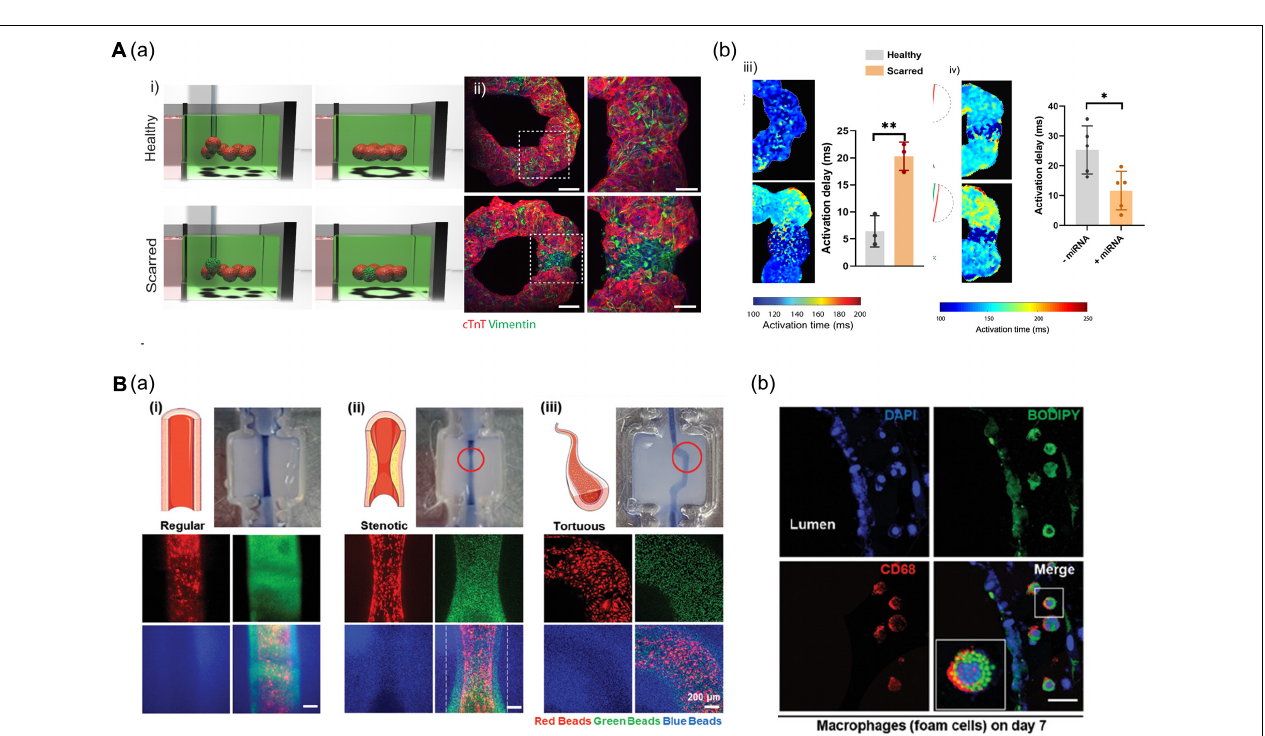
FIGURE 6 | (A) 3D bioprinting of cardiac fibrosis models. (a) Schematic diagram of the procedure for creating a cardiac fibrosis model, and immunofluorescence image of cardiac fibrosis model. (b) Disrupted electrophysiological synchronization of cardiac models, and the therapeutic effect of miRNA treatment (* p < 0.05; ** p < 0.01). Reprinted with permission from Daly et al. (2021). (B) Pathophysiological features of in vitro atherosclerosis model. (a) Structural features of the atherosclerosis model generated by adjusting the printing parameters and printing path are indicated by fluorescent beads. (b) Recapitulation of the early stages